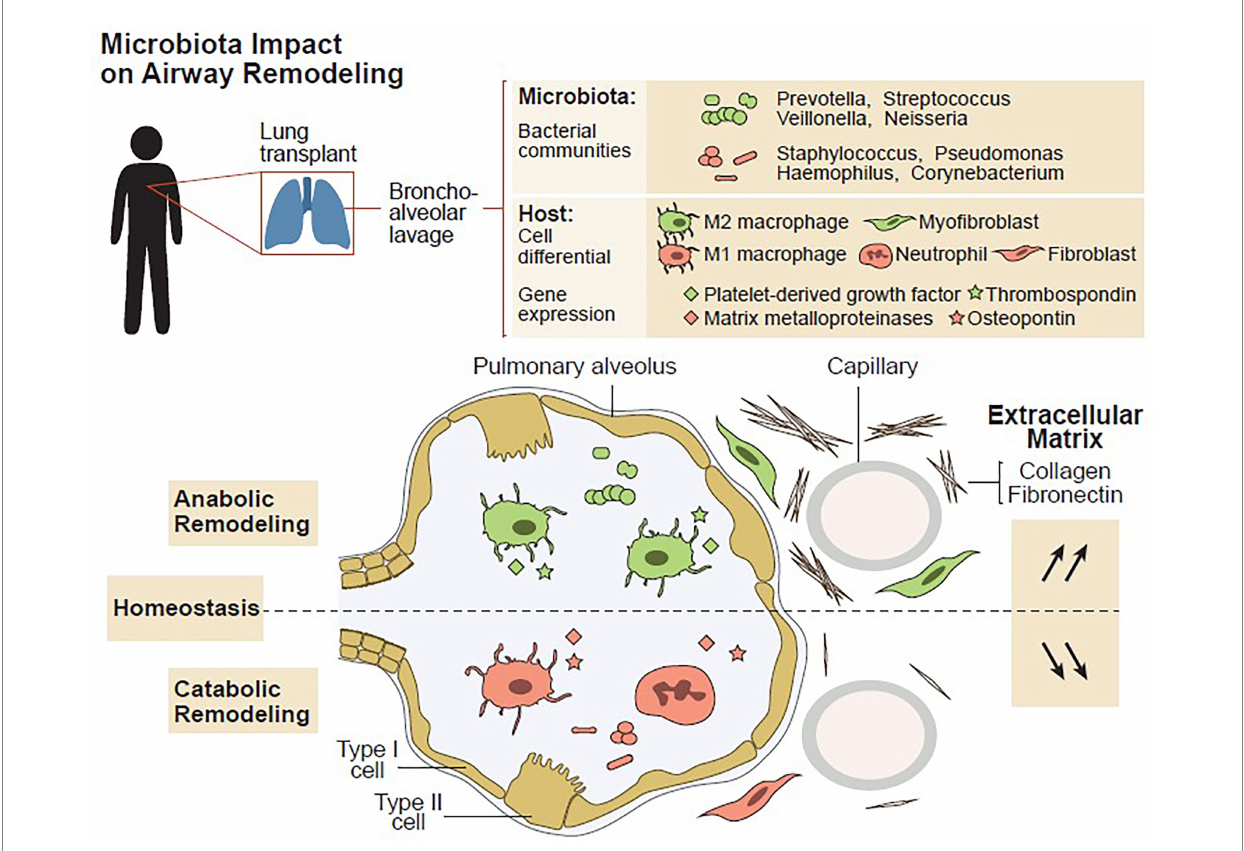
FIGURE 5 Airway microbiota signals anabolic and catabolic remodeling in the transplanted lung, graphical abstract, adapted from